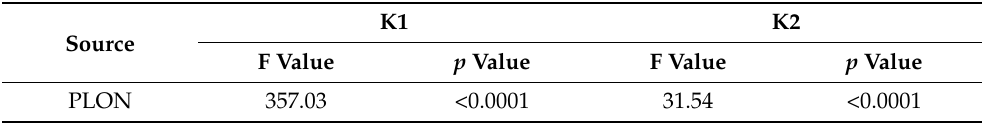
Figure 6. Typical load-deformation curve of the tested PLON block with different densities: ( a ) 20 kg/m 3 PLON block’s typical load-deformation curve, ( b ) 30 kg/m 3 PLON block’s typical load-deformation curve, ( c ) 40 kg/m 3 PLON block’s typical load-deformation curve, ( d ) 50 kg/m 3 PLON block’s typical load-deformation curve. Table 1. ANOVA results performed on three